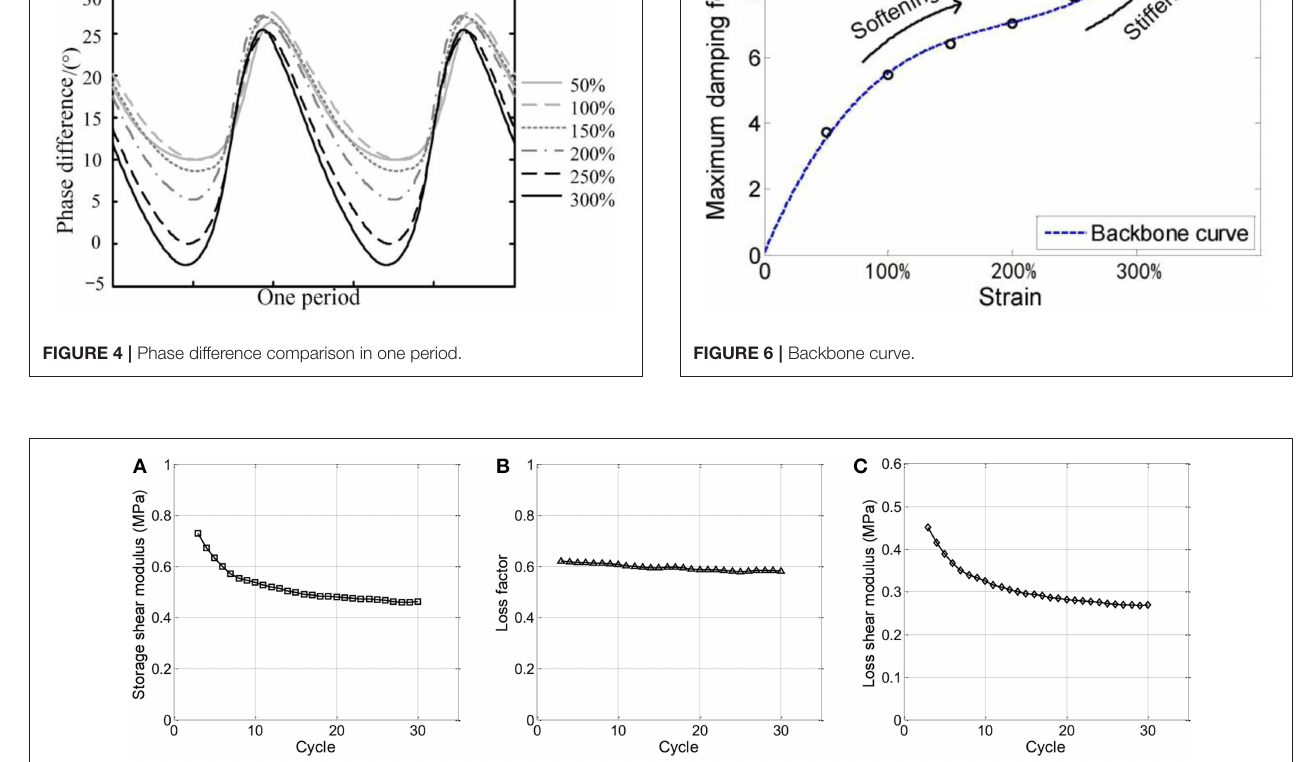
FIGURE 5 | Performance degradation law under cyclic loading on (A) storage shear modulus, (B) loss factor, and (C) loss shear modulus.